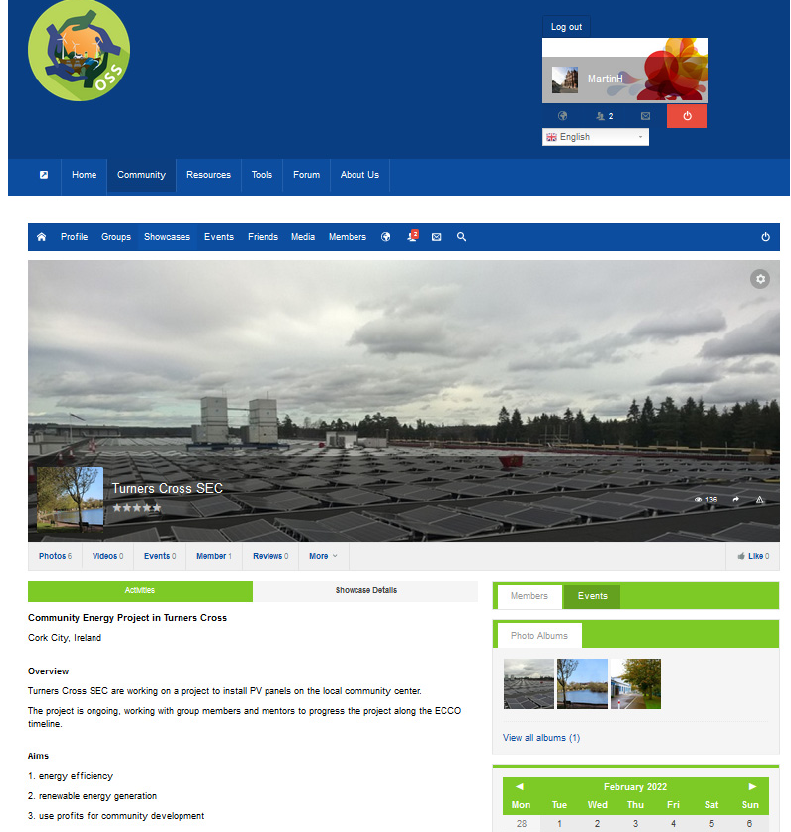
Figure 5. Project showcase sample.